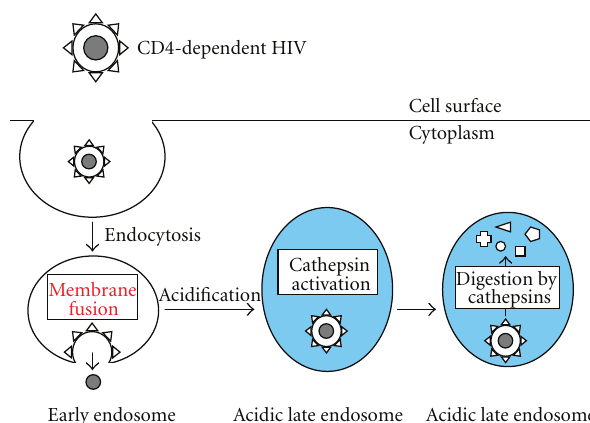
Figure 4: Entry pathway of CD4-dependent HIV. Blue area indi- cates acidic